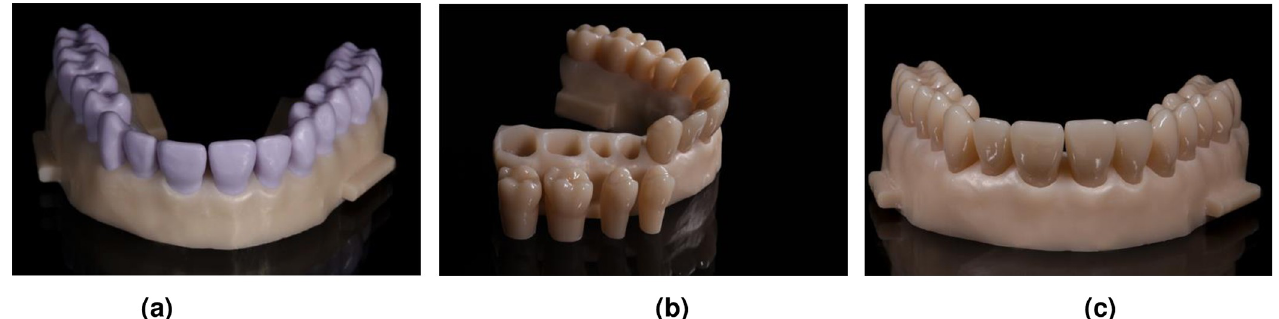
Fig 1. Reference cast with an yttrium-stabilized zirconium oxide base and lithium disilicate glass-ceramic teeth. (a) Lithium metasilicate (b) Glazed coronal surface (c) Reference cast.